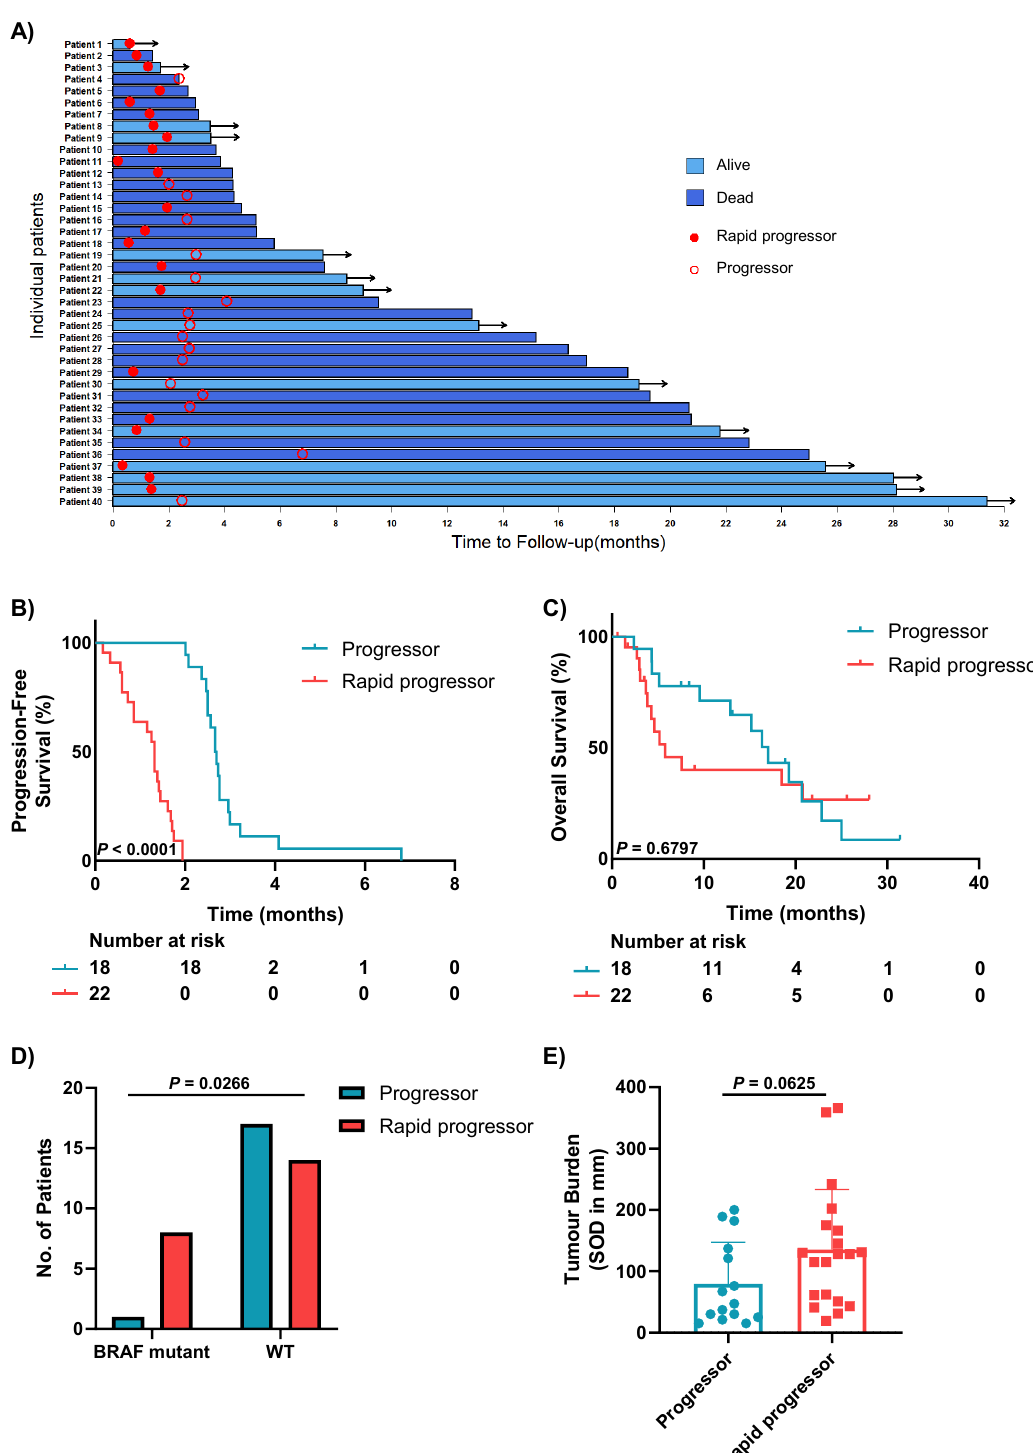
Figure 1. Clinical characteristics of non-responders to anti-PD-1-based therapies. ( A ) Swimmer’s plot illustrating the overall survival of non-responders to anti-PD-1-based therapies. Empty circle—progression; filled circle—rapid progression; dark blue—dead; light blue with arrow—alive. ( B ) Kaplan–Meier curves demonstrating significantly shorter progression-free survival in rapid progressors compared to progressors. ( C ) Kaplan–Meier curves demonstrating no significant difference in overall survival between rapid progressors and progressors. ( D ) Bar graph showing the proportion of progressors and rapid progressors with BRAF mutations, assessed using the Fisher’s exact test. ( E ) Box plot comparing tumour burden (measured as the sum of diameters in mm) between rapid progressors and progressors. Error bars represent mean ±